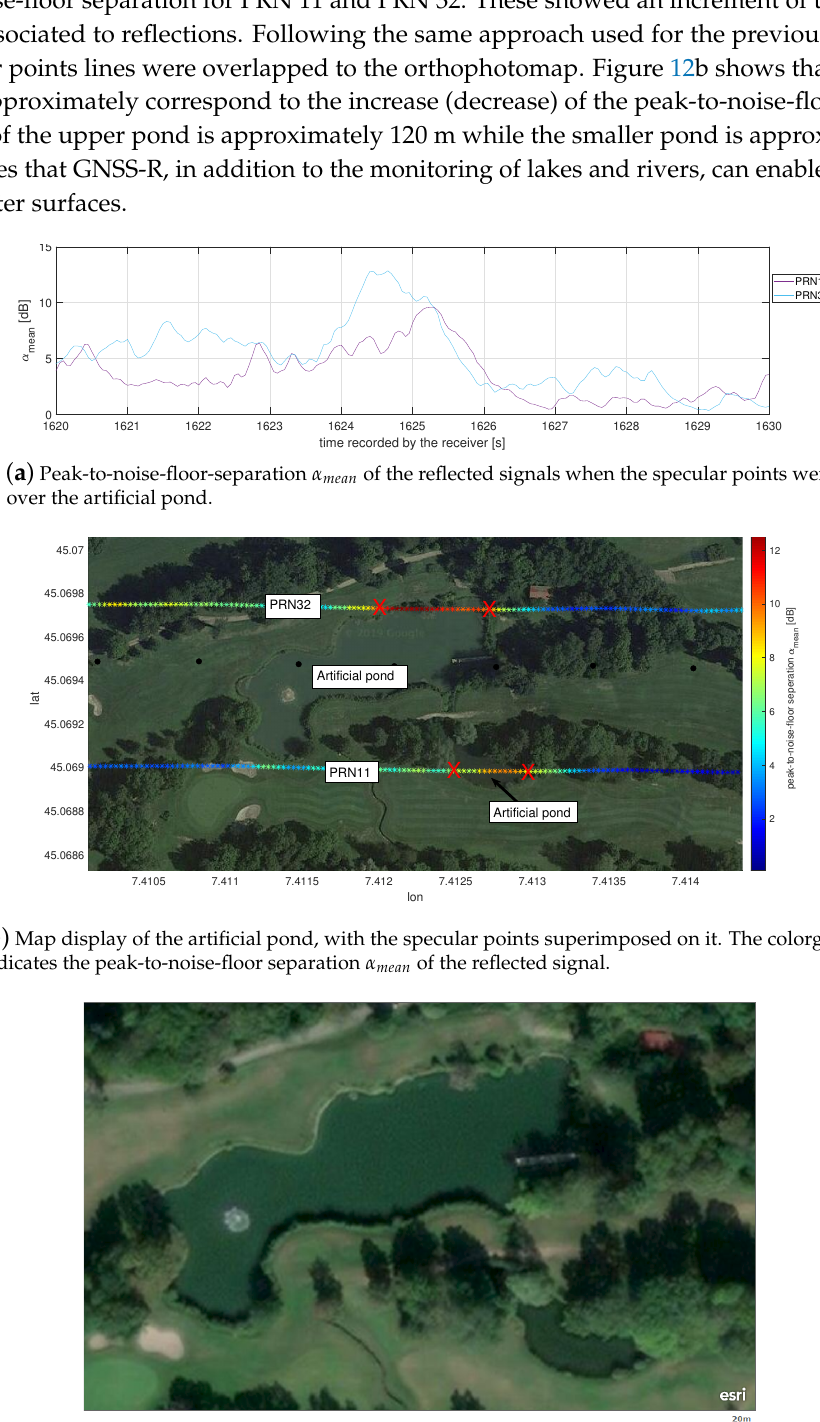
( c ) Image of the two ponds. Figure 12. Example of the detection of an artificial pond taken from data set